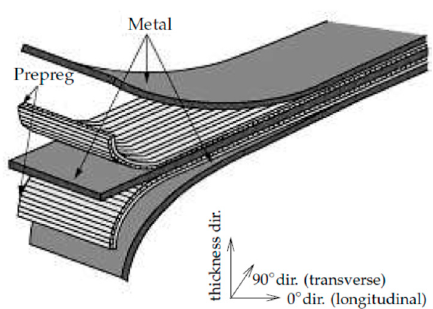
Figure 3. Typical configuration of glass aluminium-reinforced epoxy (GLARE) [128].